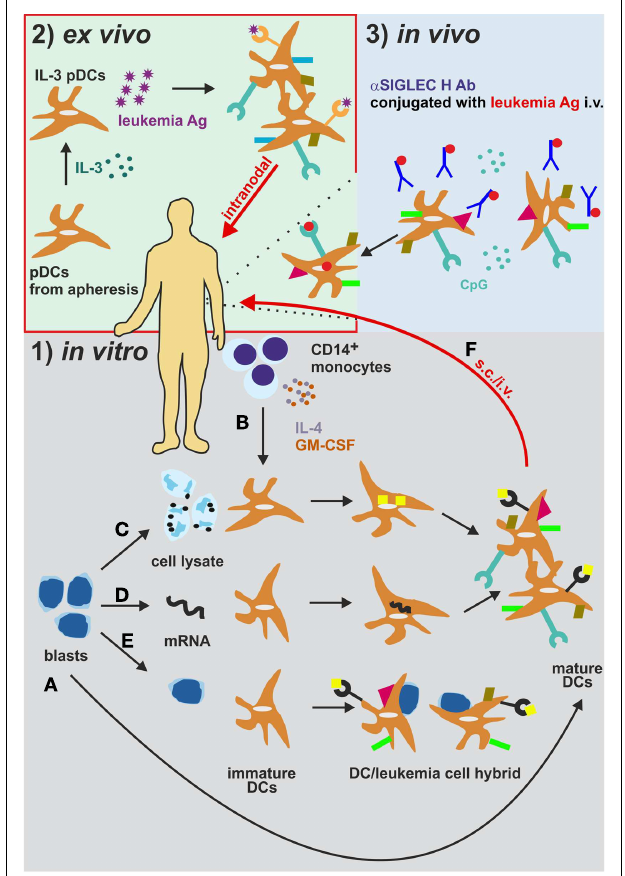
FIGURE 3 | Different strategies for the generation and administration of DC-based vaccines inAML . (1) (A) Leukemia-derived DCs can be directly generated by isolation and differentiation from AML blasts in vitro . (B) CD14 + monocytes from patients or healthy donors are differentiated into monocyte-derived DCs (mDCs).These mDCs are cultured together with (C) AML cell lysates or immunogenic apoptotic/necrotic AML cells (185) or (D) are electroporated with mRNA from AML cells (191) to ensure leukemia antigen loading. (E) As an additional in vitro approach, AML blast-mDC cell-fusion hybrids are artificially generated (196). (F) The DCs are then injected s.c. or i.v. into AML patients. (2) DCs can also be loaded and activated in vivo (188). DCs express the endocytosis receptor SIGLEC. Intravenous administration of an α SIGLEC H mAb conjugated to a leukemia antigen in the presence of CpG results in DC activation, antigen uptake and presentation. (3) Plasmacytoid DCs isolated from AML patients are activated and loaded with leukemia antigens ex vivo and are re-injected intralymphatically into lymph nodes (201). Ab, antibody; Ag, antigen; i.v. intravenously; pDCs, plasmacytoid DCs. s.c.,